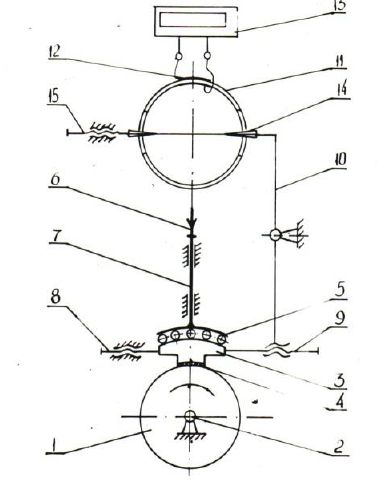
Fig. 5. General view of the strain gauge device for